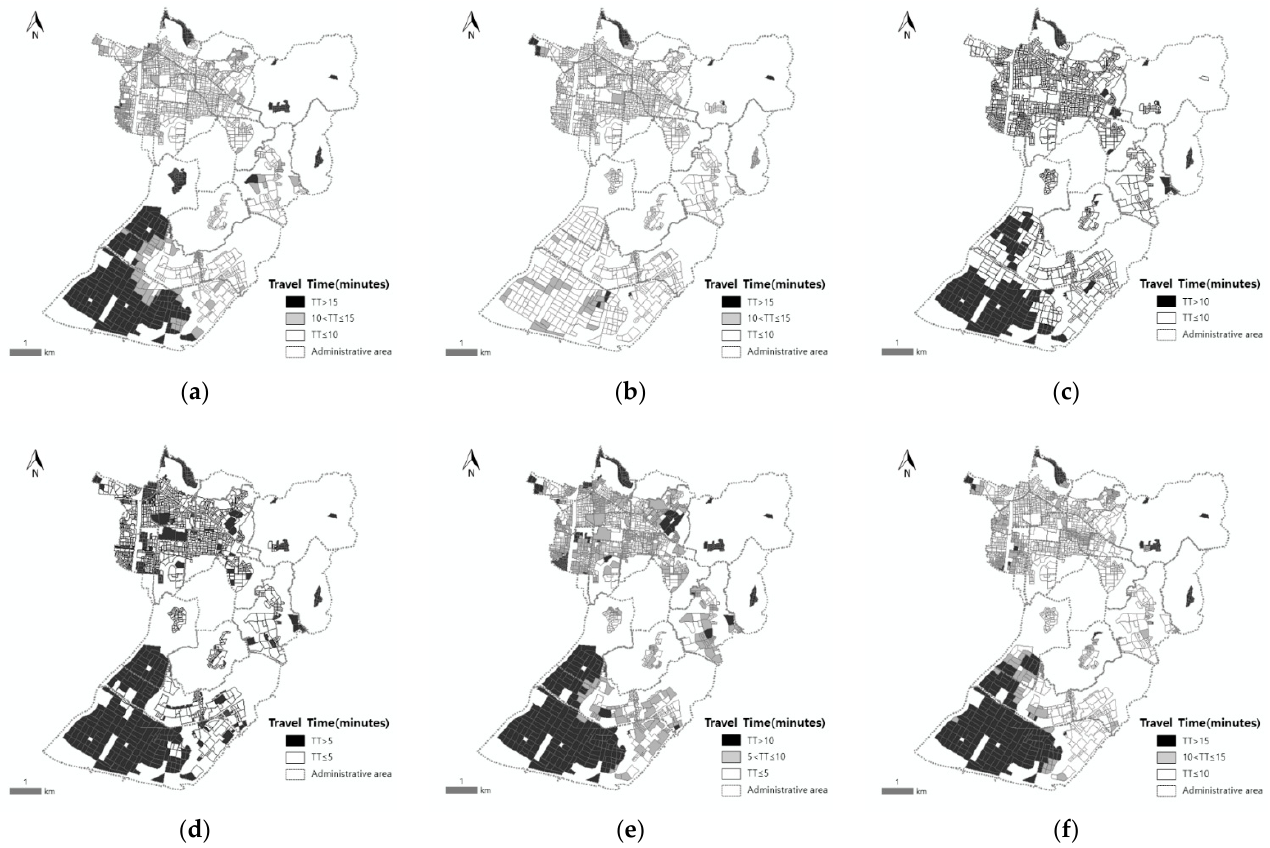
Figure 5. Maps of residential areas with poor access—walking time: ( a ) library; ( b ) park; ( c ) sports facility; ( d ) childcare center; ( e ) kindergarten; ( f ) elementary school.